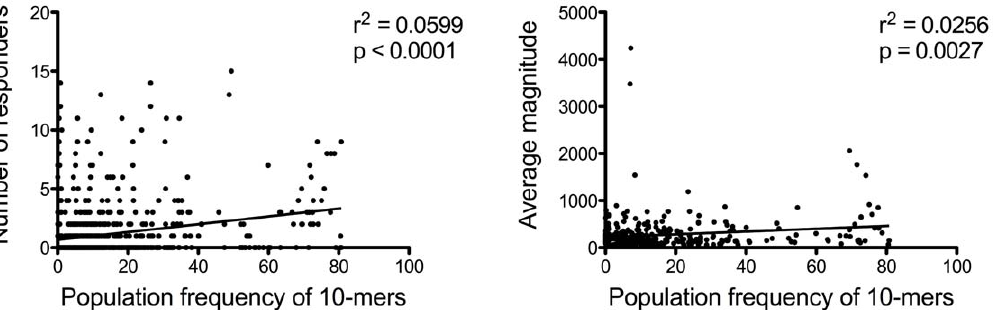
Figure 6. Population frequency of HIV-1-B Nef peptides and IFN- c ELISpot responses. The frequency of each unique 10-mer in a dataset of 514 independent Nef HIV-1 subtype B sequences is shown. Peptide reactivity data generated by IFN- c ELISpot assays done on 26 HIV-1 infected individuals were used to analyze the relationship between the population frequency of a peptide and either its frequency of recognition in the cohort (7A – left panel) or the magnitude of the IFN- c ELISpot responses c ELISpot response it elicited (7B – right panel).